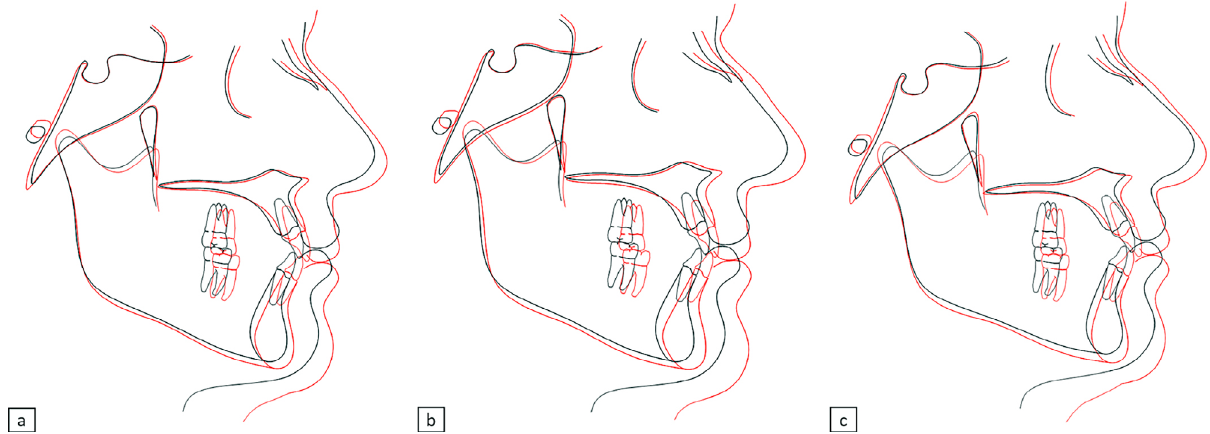
Figure 2- Facial and regional tracing superimposed in the cranial base, centered at S (T1-black; T2-red). a – Average of complete sample. b – Average of male subjects; c - Average of female